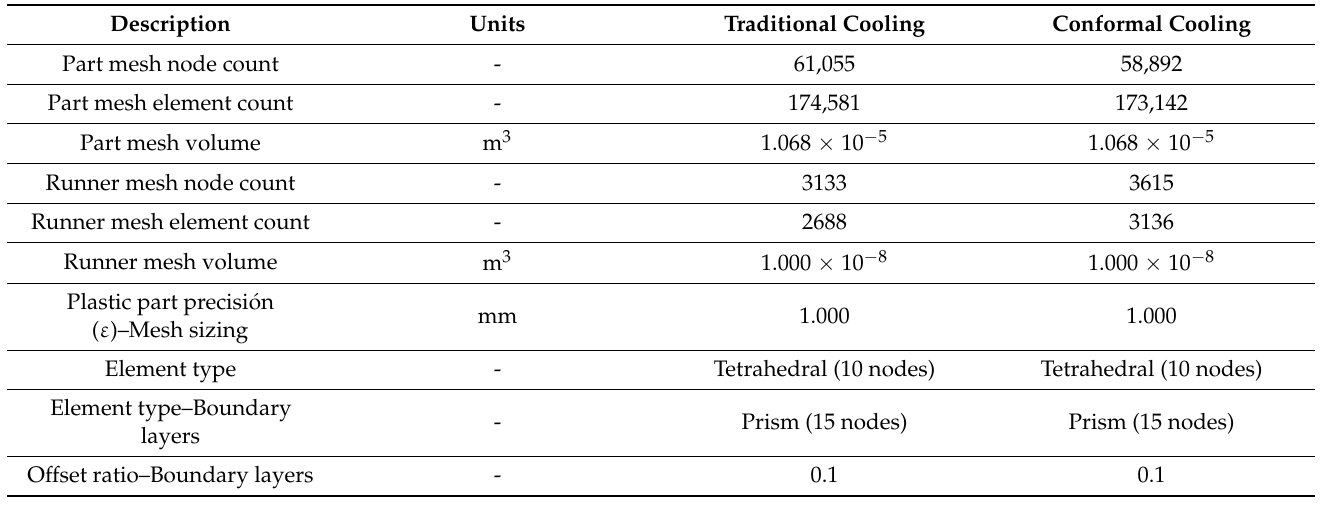
Table 7. Mesh statistics for the traditional and conformal cooling meshes.